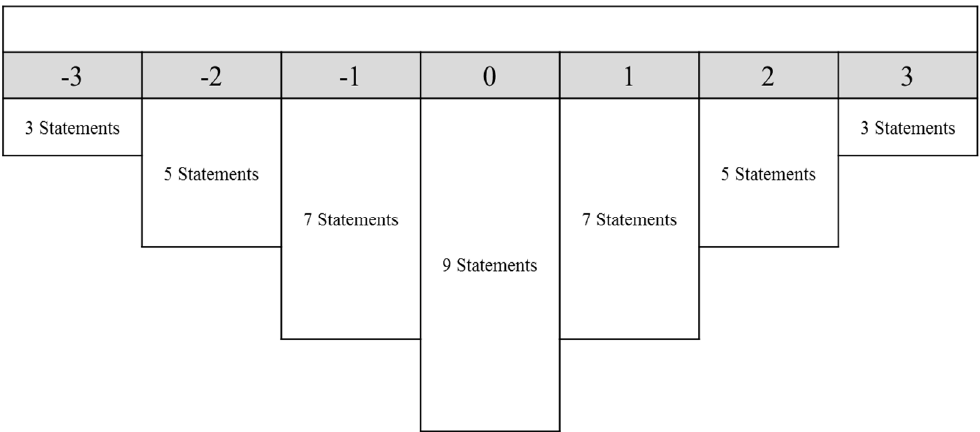
Figure 1. Q Methodology scale. Distribution of statements as ranked by participants in seven main categories.